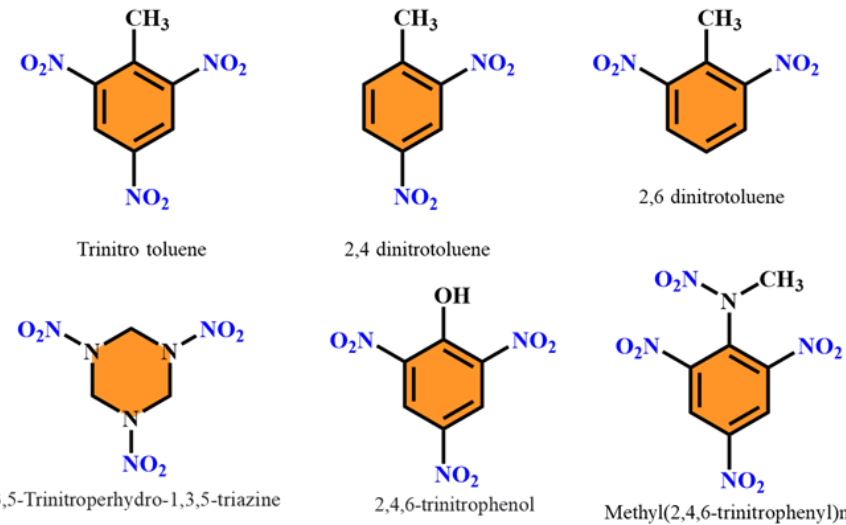
Figure 9. Chemical structures of nitroaromatic explosive compounds.